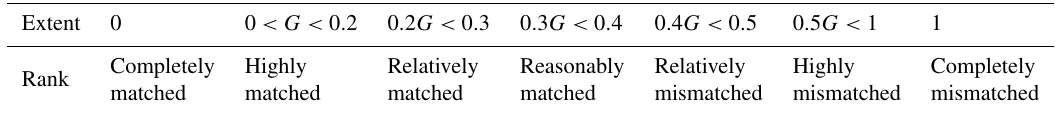
Table 2. Division of threshold value of the Gini